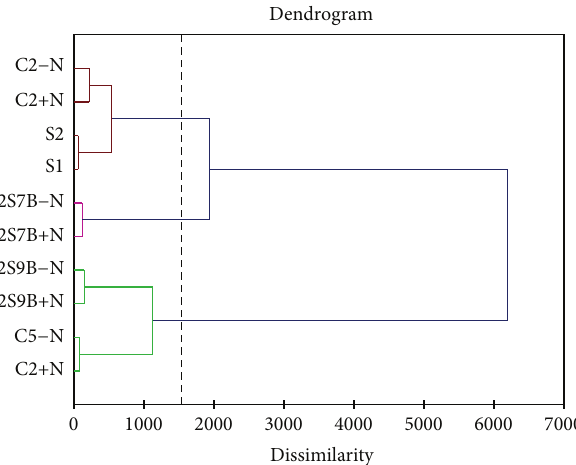
Figure 3: Dendrogram for the HCA results using Ward’s clustering